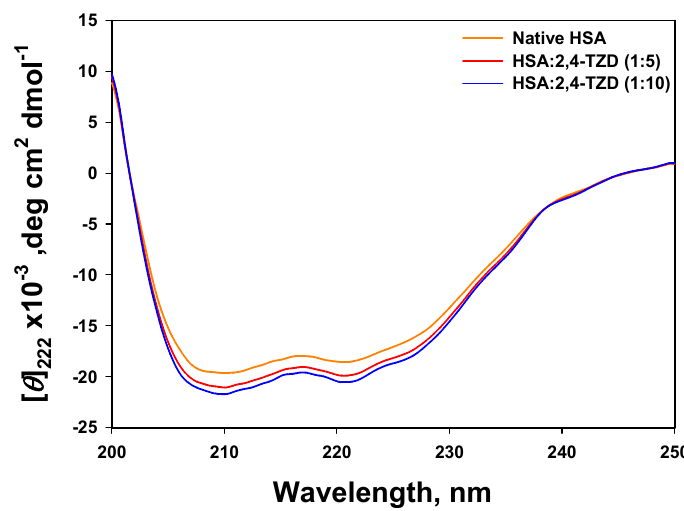
ff erent HSA to 2,4-TZD molar ratios.